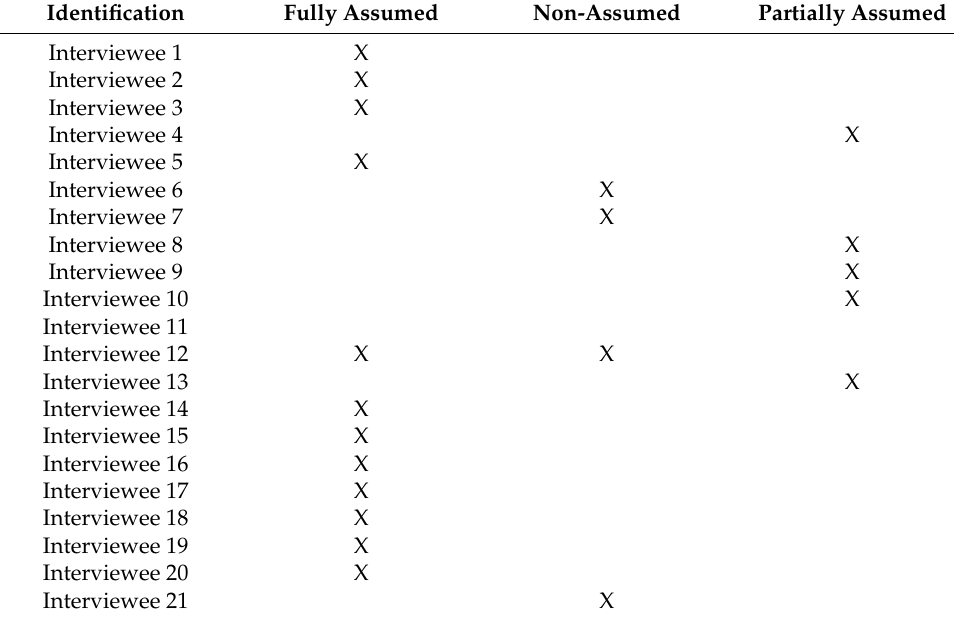
Table 3. Workers’ identity in the